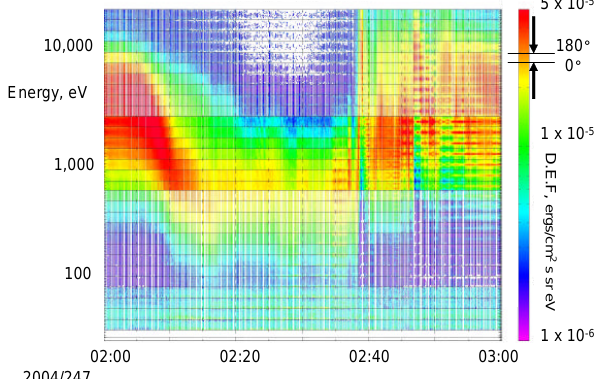
Figure 14. Example of ground-based estimation of spacecraft potential Fig. 14. Example of ground-based estimation of spacecraft poten-